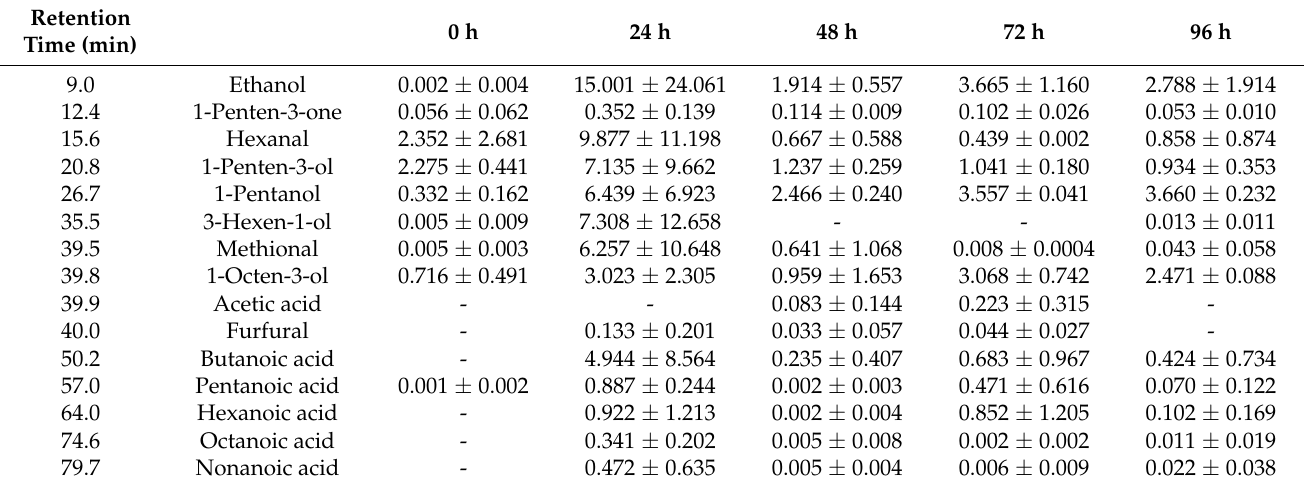
Table 1. Volatile components in the fish sauce, with concentration of each component based on the internal standard (2.439 ppm) ( n =